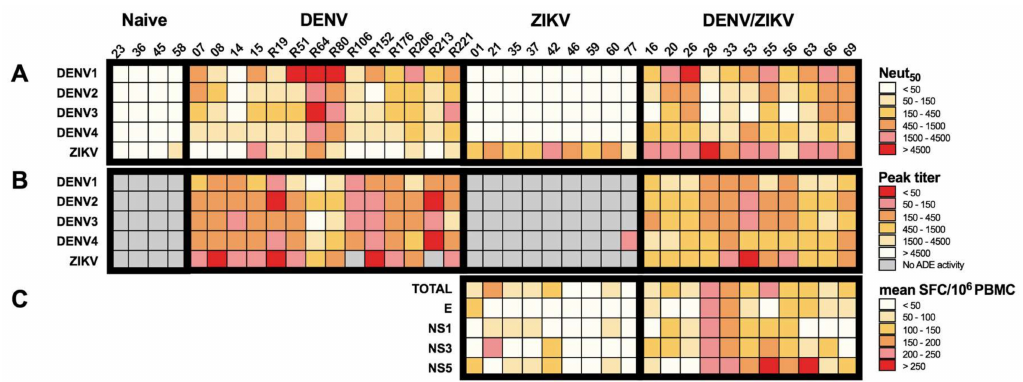
Figure 5. Specificity and cross-reactivity of antibody and T-cell responses from donors with DENV and/or ZIKV infection. ( A ) Heat map of the neutralizing activity of plasma samples from DENV-immune ZIKV-naïve, ZIKV-immune DENV-naïve, and DEN/ZIKV-immune donors on DENV1-4 and ZIKV infection. ( B ) Heat map of the ADE activity of plasma samples from DENV-immune ZIKV-naïve, ZIKV-immune DENV-naïve, and DENV/ZIKV-immune donors on DENV1-4 and ZIKV infection; ( C ) Heat map of the mean T-cell response against peptides from the whole ZIKV proteome (TOTAL) or the immunodominant proteins of PBMCs from ZIKV-immune DENV-naïve and DENV/ZIKV-immune donors; each column represents one